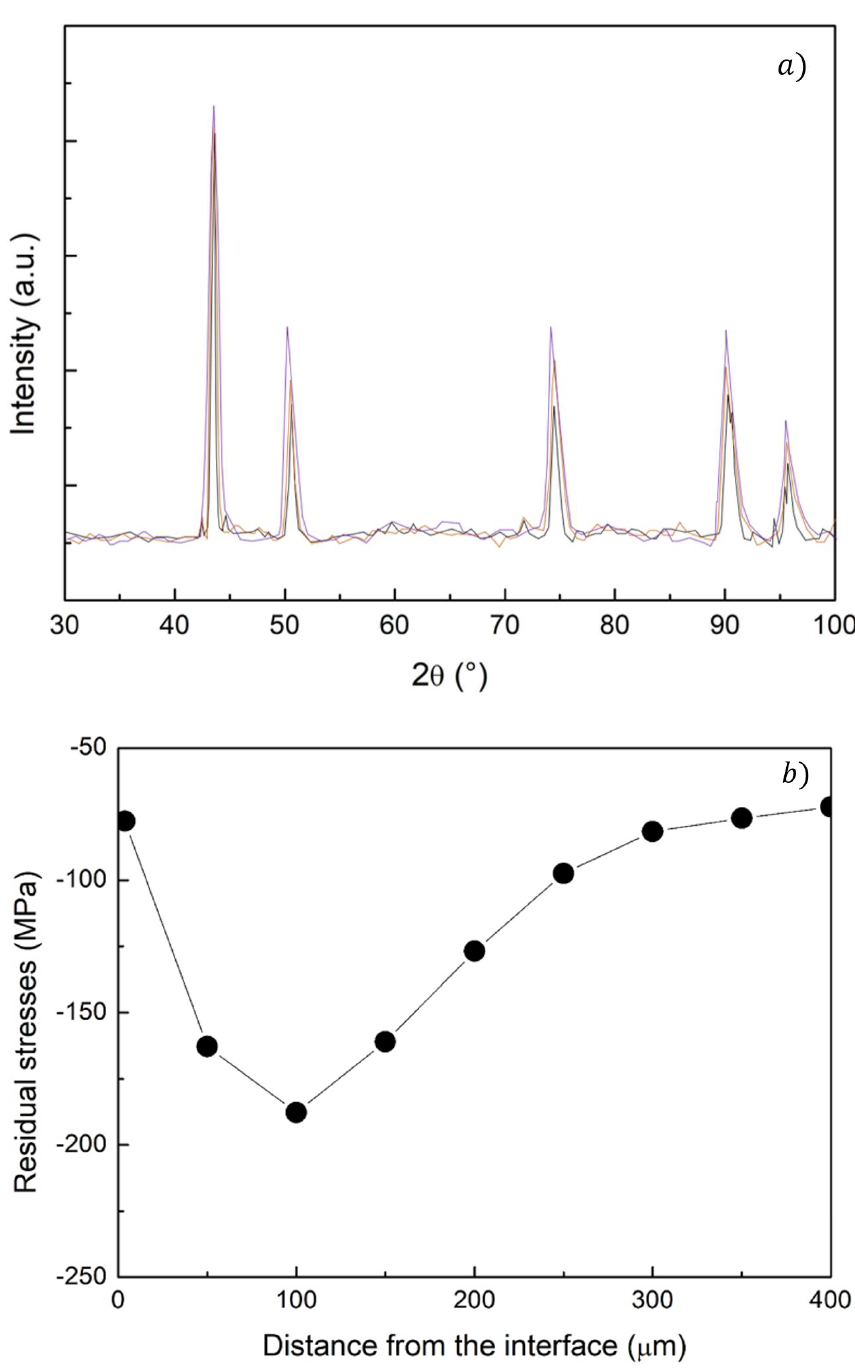
Figure 7. XRD peak broadening ( a ); residual stresses measured from XRD peak broadening ( b